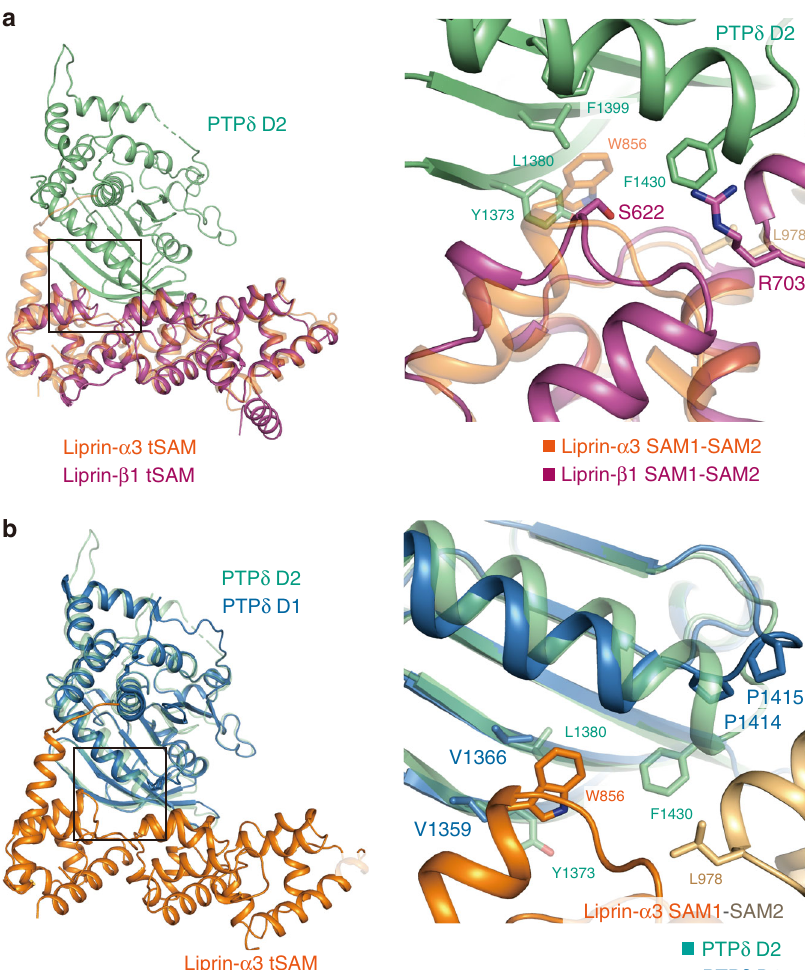
Fig. 3 Structural comparisons between Liprin- α and - β and between PTP δ D2 and D1. a Superposition of Liprin- β 1 (purple) on Liprin- α 3 (orange) bound to PTP δ D2 (green). The residues involved in the PTP δ D2 – Liprin- α 3 tSAM interaction and the corresponding residues of Liprin- β 1 are shown as sticks in the right panel. b Superposition of PTP δ D1 (blue) on PTP δ D2 (green) bound to Liprin- α 3 tSAM (SAM1, orange; SAM2, light brown). The residues involved in the PTP δ D2 – Liprin- α 3 tSAM interaction and the corresponding residues of PTP δ D1 are shown as sticks in the right